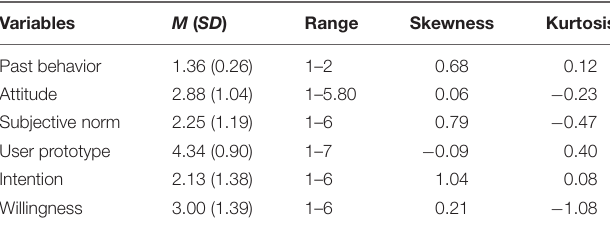
TABLE 1 | Descriptive statistics for all variables included in SEM.